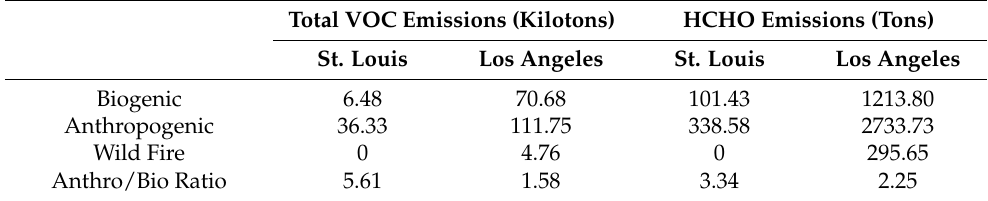
Table 3. 2008 NEI total VOC and HCHO emissions at St. Louis and Los Angeles county, along with anthropogenic to biogenic emissions